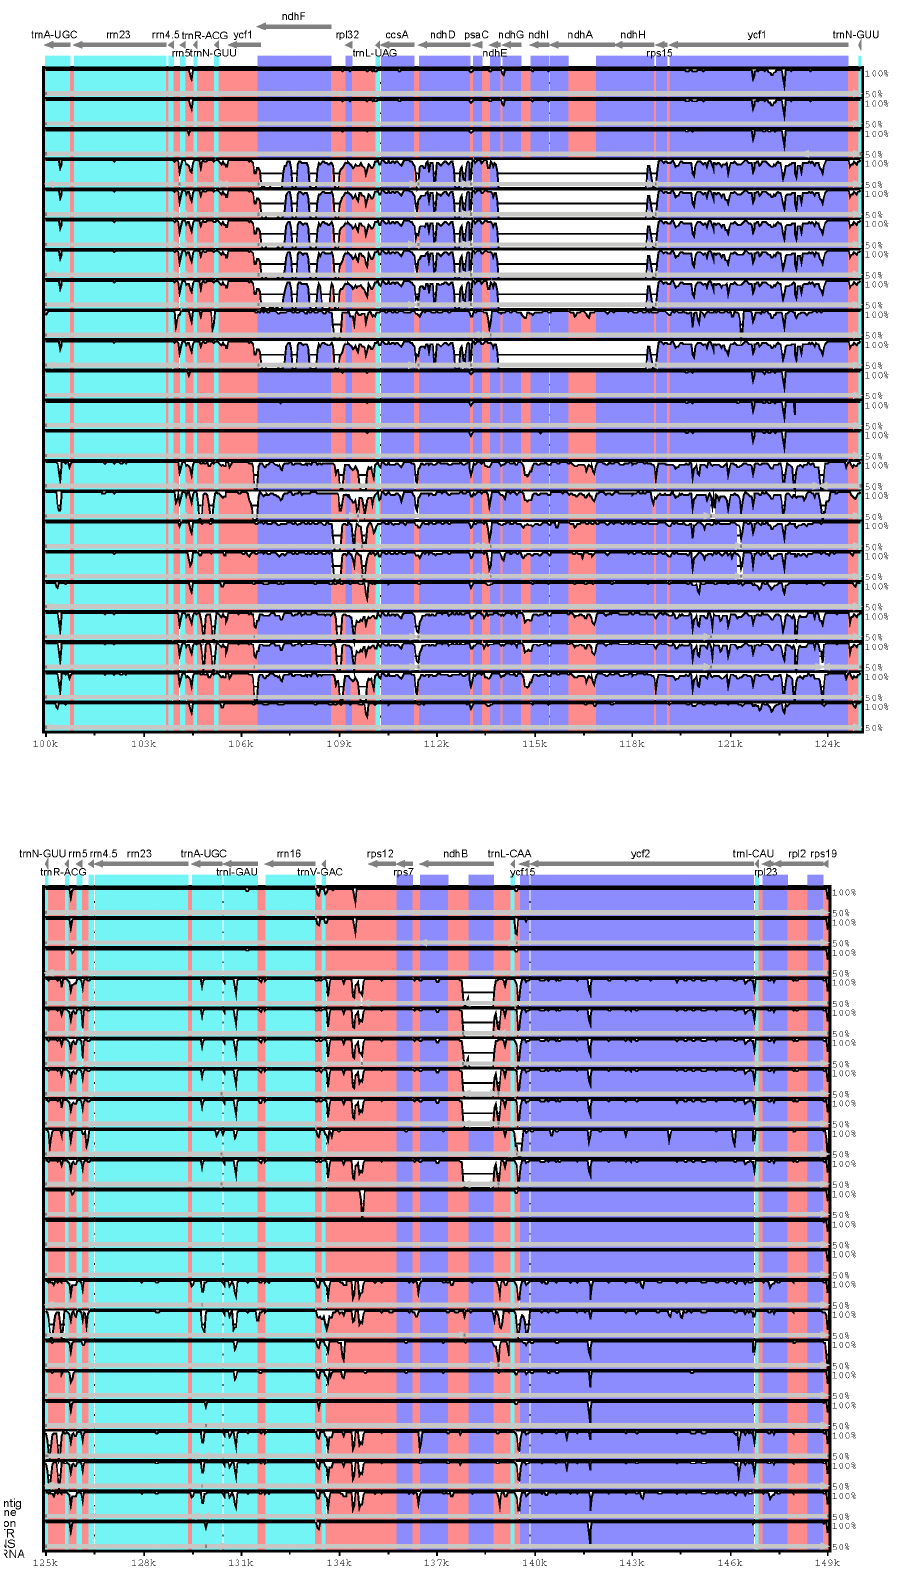
Supplement Fig. 1: Comparison of the plastomes in Gentiana genus by using mVISTA. The genes are represented as gray arrows on the top of the alignments. The different regions are labeled with different colors. The pink regions are “conserved noncoding sequences” (CNS), the dark blue regions are exons, and the light-blue regions are tRNAs or rRNAs. The percentages 50 and 100% refer to the similarity among sequences. The gray arrows above the aligned sequences represent genes and their